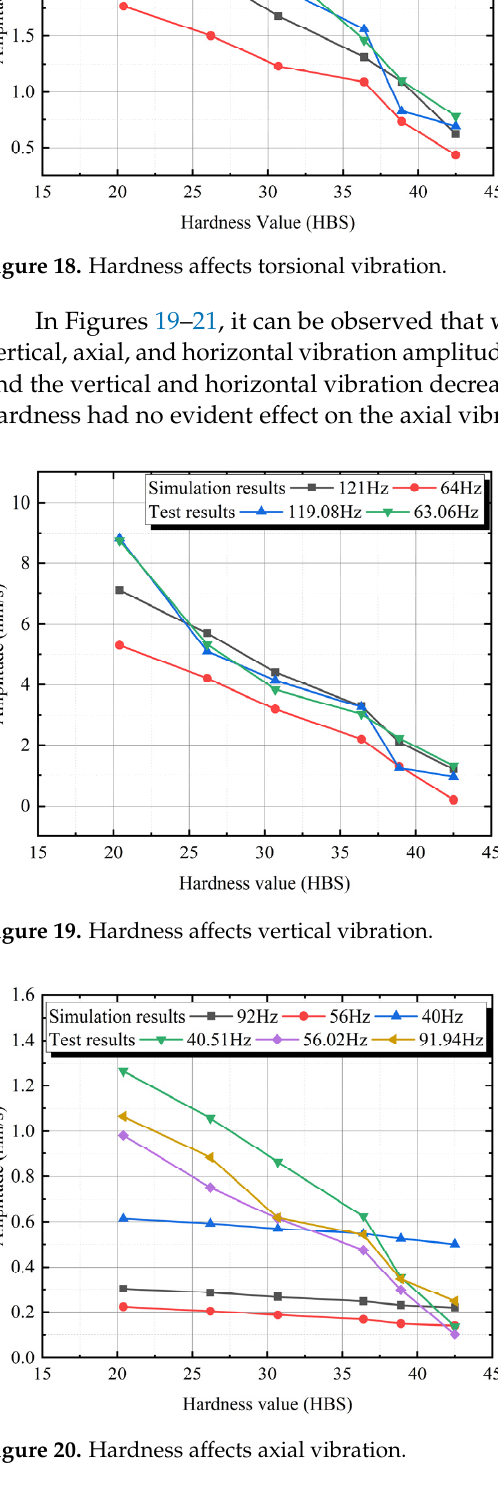
Figure 21. Hardness affects horizontal vibration . 4. Conclusions In our current research, the entire F3 rolling mill of the MCCR finishing mill was analyzed as the main object, and the effects of the thickness and hardness fluctuations of the strip steel at the entrance of the rolling mill on the torsional, vertical, and axial vibra- tions were examined. The following conclusions were drawn: (1)